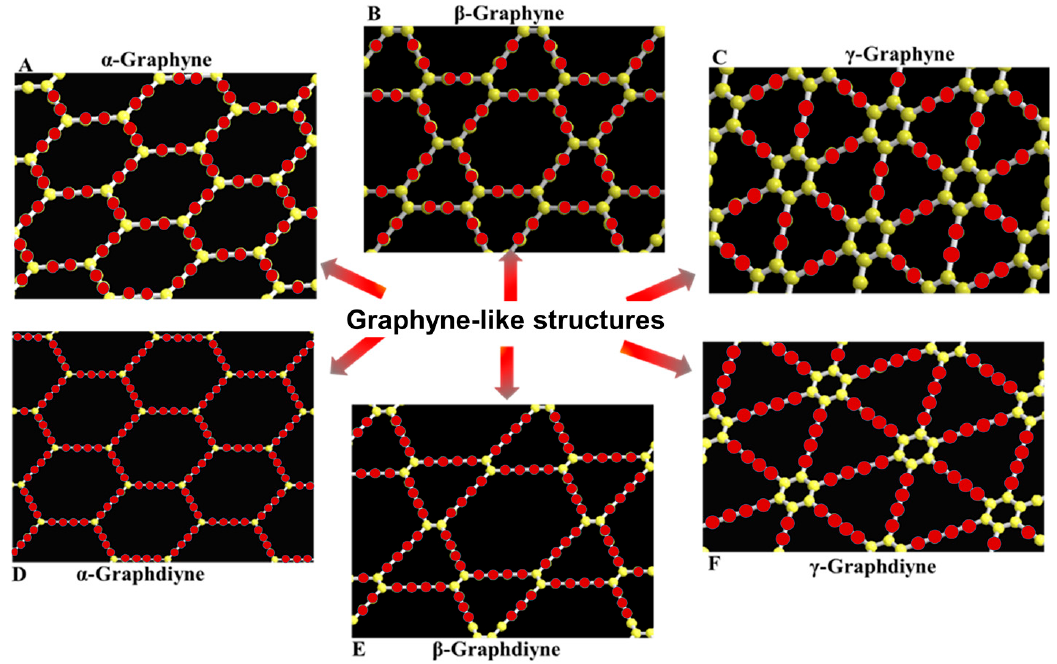
Figure 2. Representation of different graphyne and graphdiyne–like structures. α -graphyne ( A ); β -graphyne ( B ); γ -grapyne ( C ); α -graphdiyne ( D ); β -graphdiyne ( E ); γ -graphdiyne ( F ). The red dots represent acetylenic (graphynes) and diacetylenic (graphdiynes) bridges (Csp) and yellow ones—sp 2 hybridized carbons.